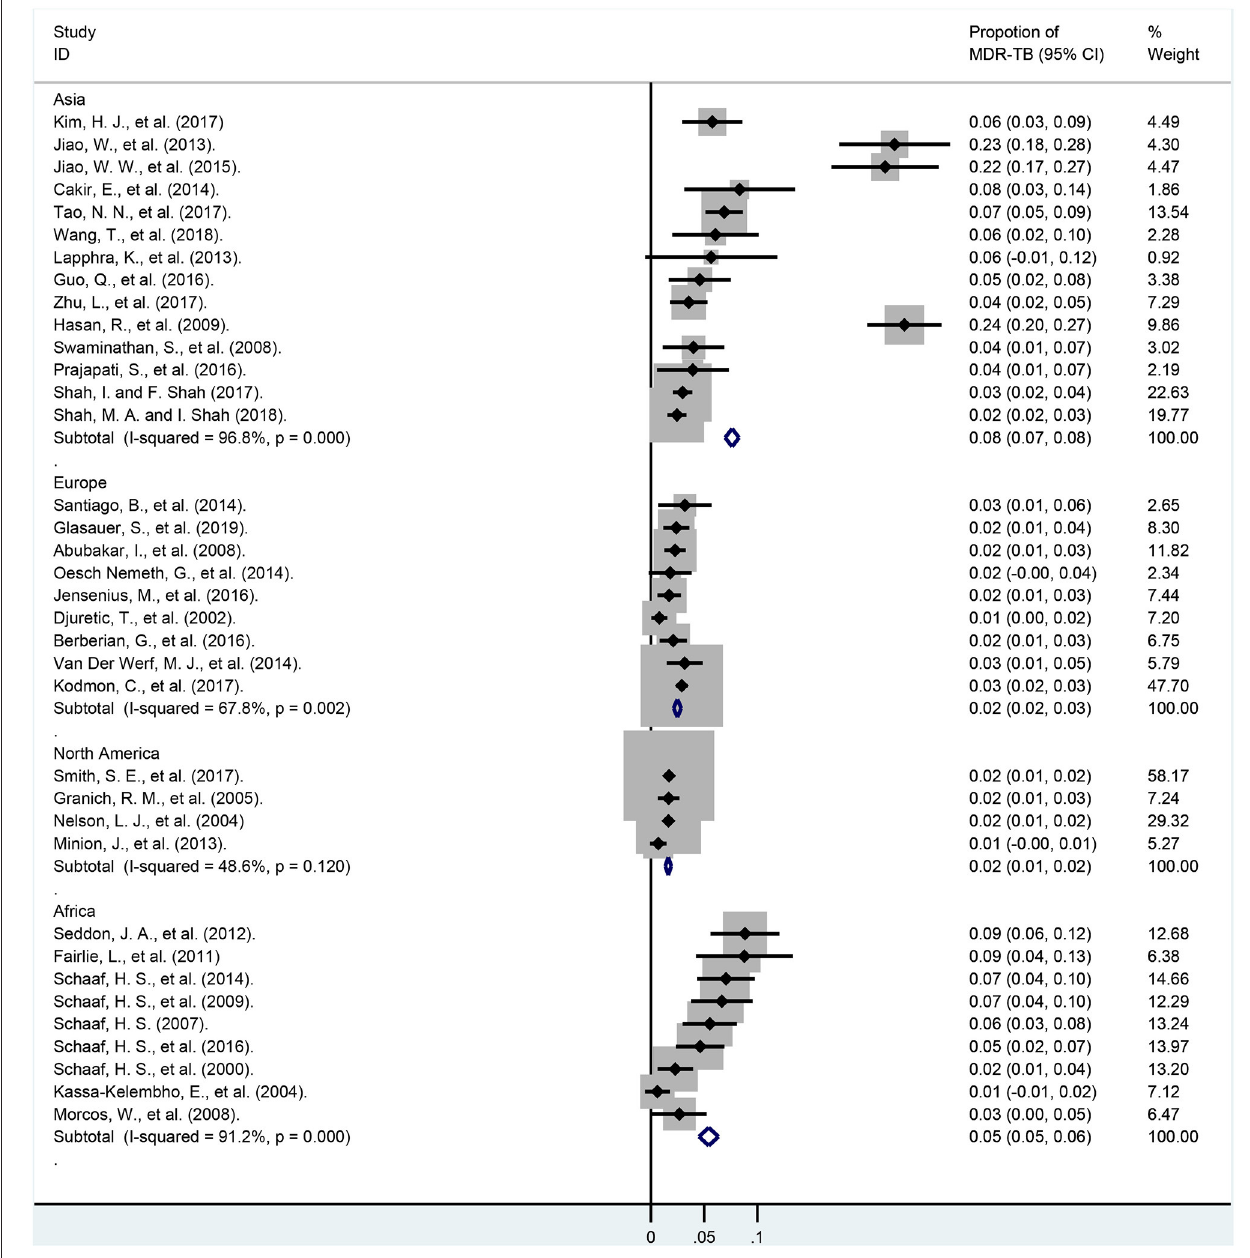
85.3%, df = 1, P = 0.009; UK), 2.9% (95% CI, 2.2–3.5%; I ² = 0.0%, df = 3, P = 0.599; India), 6.0% (95% CI, 5.0– 7.1%; I ² = 95.8%, df = 5, P < 0.001; South Africa), 9.8% (95% CI, 8.5–11.0%; I ² = 95.80%, df = 5, P < 0.001; China),